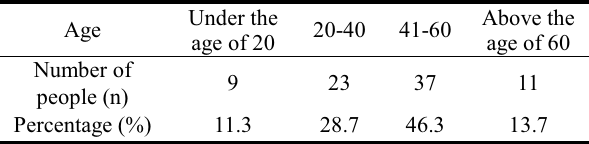
Table 1 Sponsor types of the "dragon boat race" of folk sports in